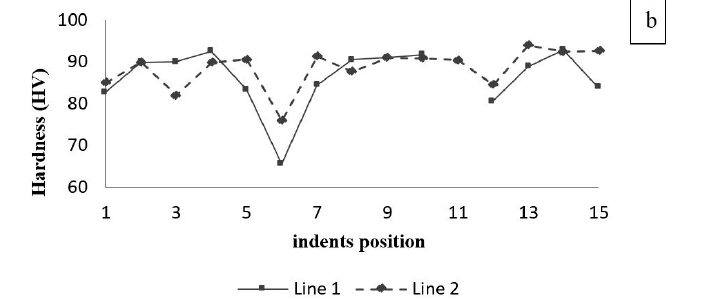
Figure 8. ( a ) IPF map of the banded structure and ( b ) hardness profile in the banded structure